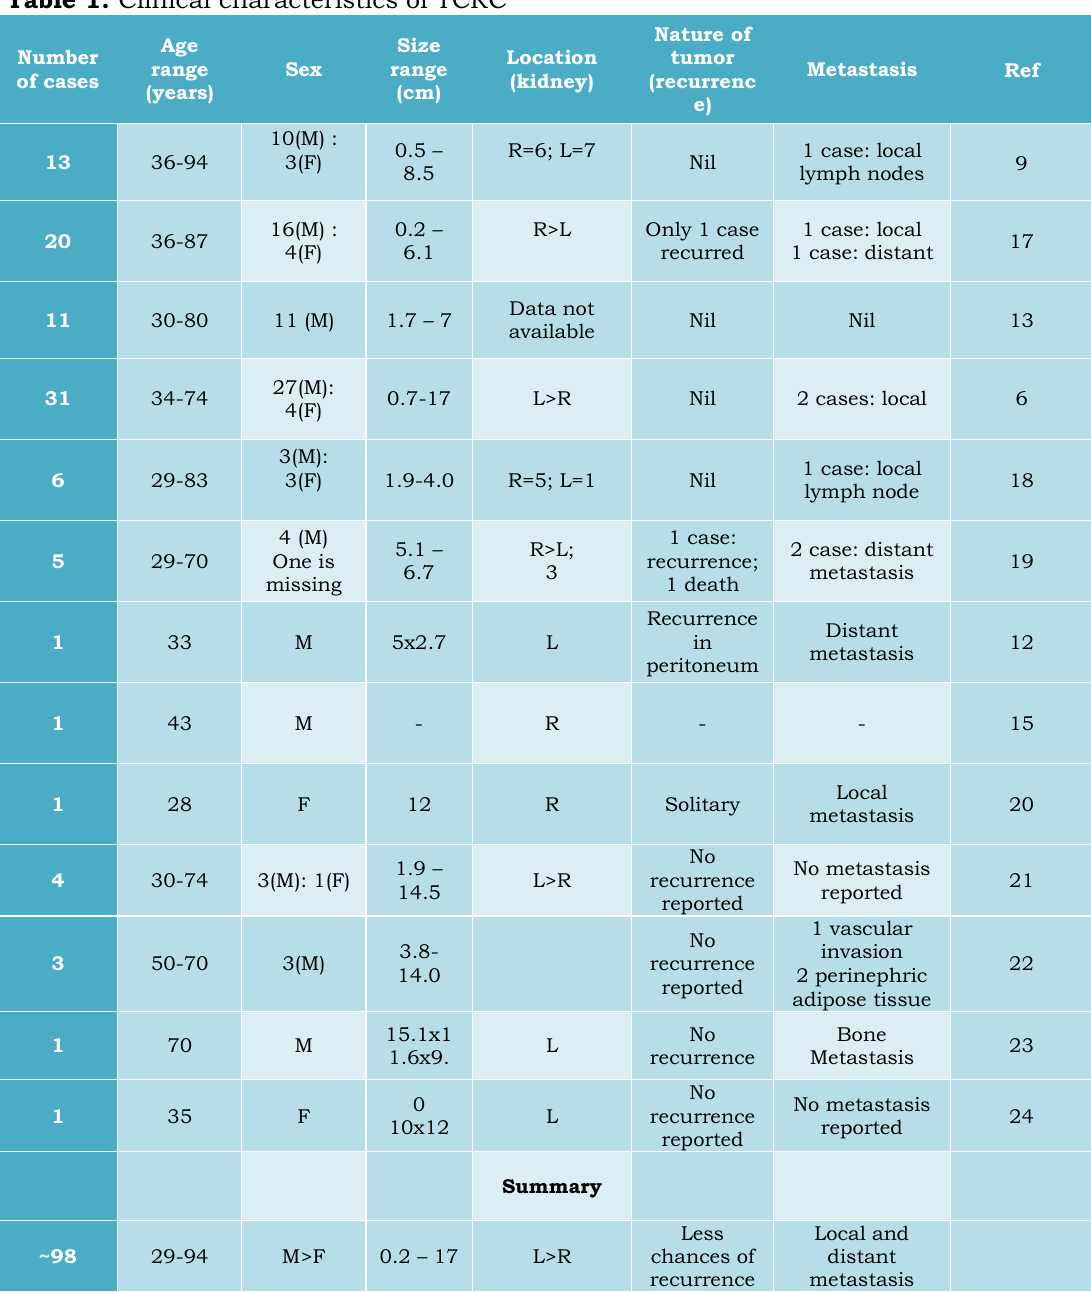
Table 1: Clinical characteristics of TCRC Number of